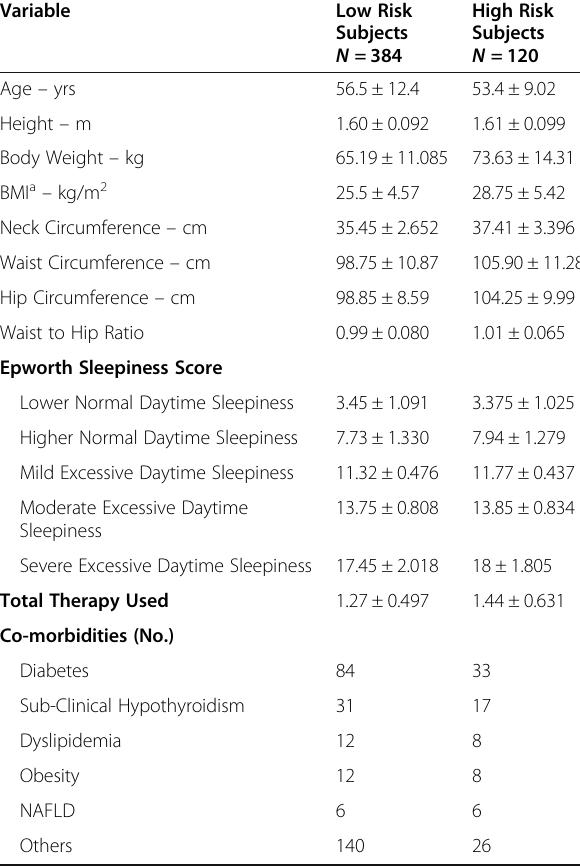
Table 1 Baseline demographic and clinical characteristics of the study